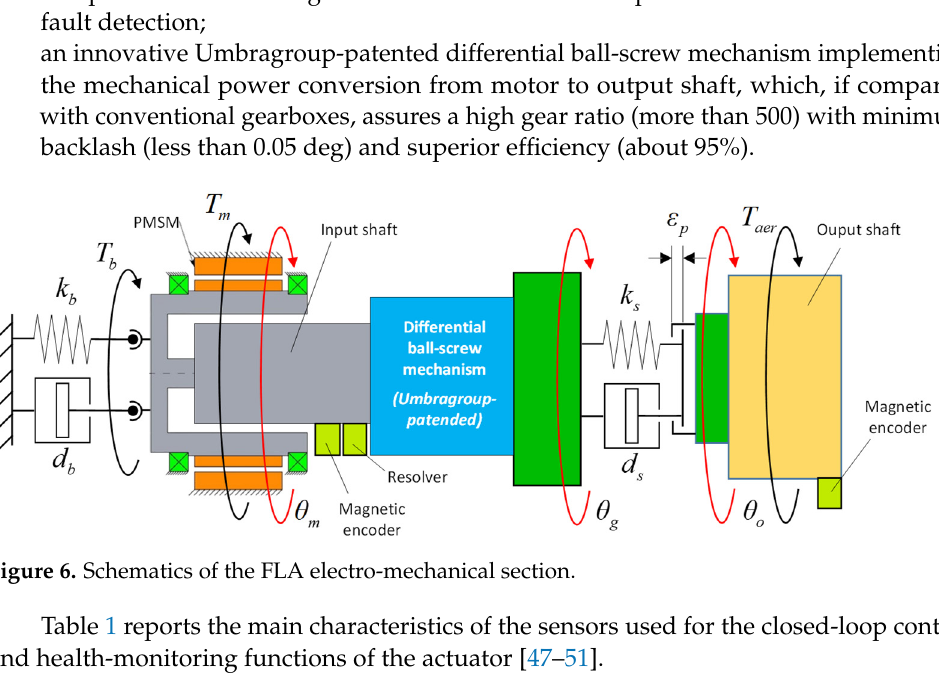
Table 1. EMA control sensors data.